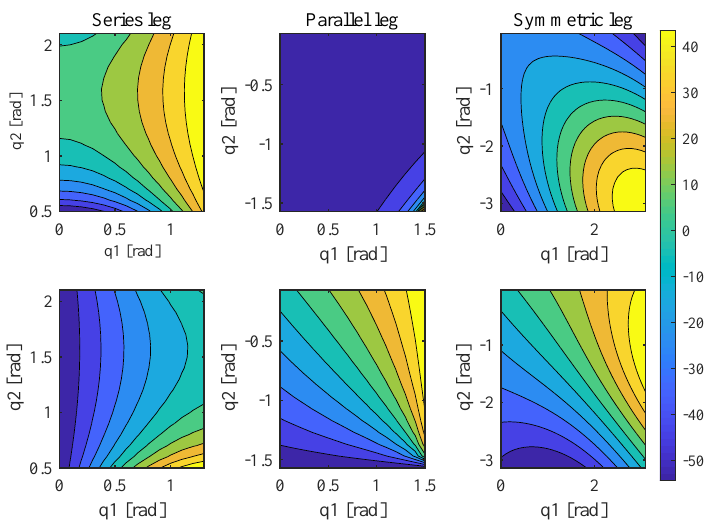
Figure 4. The force production of three kinds of leg topology. The first and second line are horizontal and vertical foot force of the three types of leg, respectively; color bar represents the force value (N).